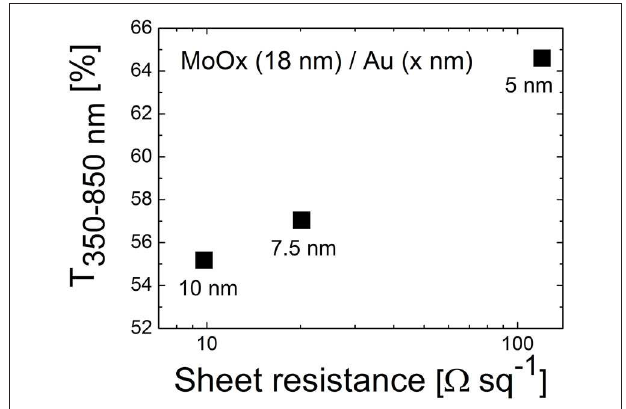
TABLE 1 | Sheet resistance (R s ) of electrodes based on ultrathin Au films (10nm) on glass or PET substrates; electrodes were fabricated with and without a seed layer of SnO 2 ( ∼ 25nm) and MoO x (18nm), and with and without a top SnO 2 layer ( ∼ 15nm); average R s , reported in brackets, was calculated over measurements on samples of different batches.